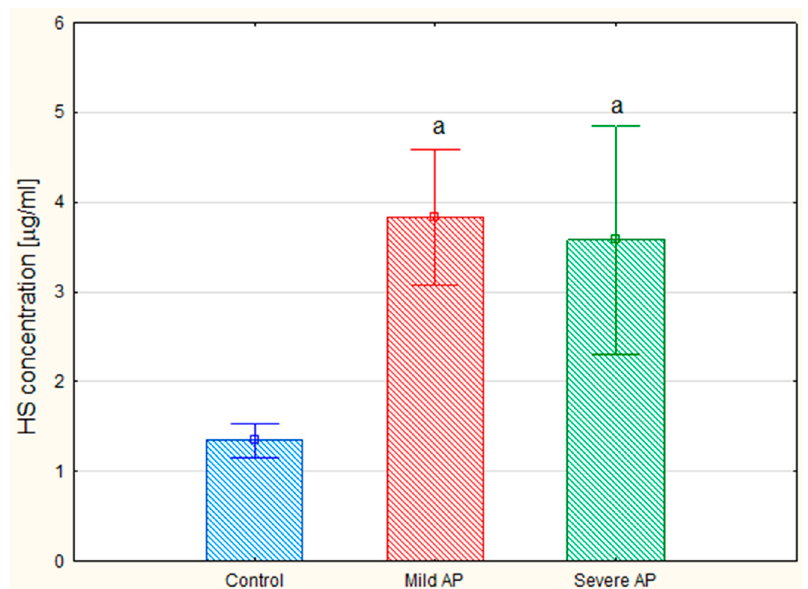
Figure 4. Concentrations of the circulating chondroitin sulfate (CS) in the healthy controls and the patients with mild or severe acute pancreatitis (AP). CS was identified in the samples of plasma glycosaminoglycans using a combination of electrophoresis on the cellulose acetate and specific degradation with chondroitinase ABC. Data are presented as means ± SD. a—differences statistically significant ( p < 0.05) compared to the healthy controls.